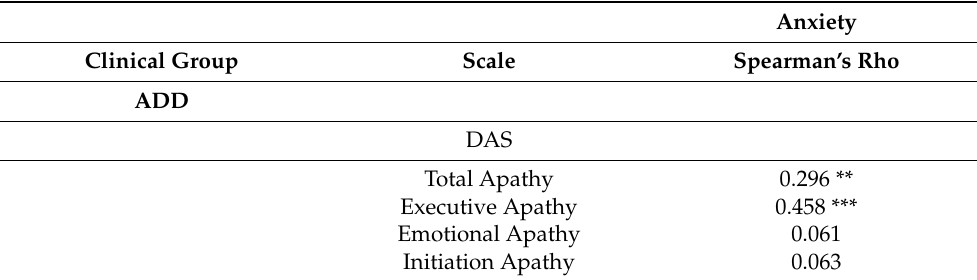
Table 8. Correlations between DAS apathy & DASS anxiety among the different clinical